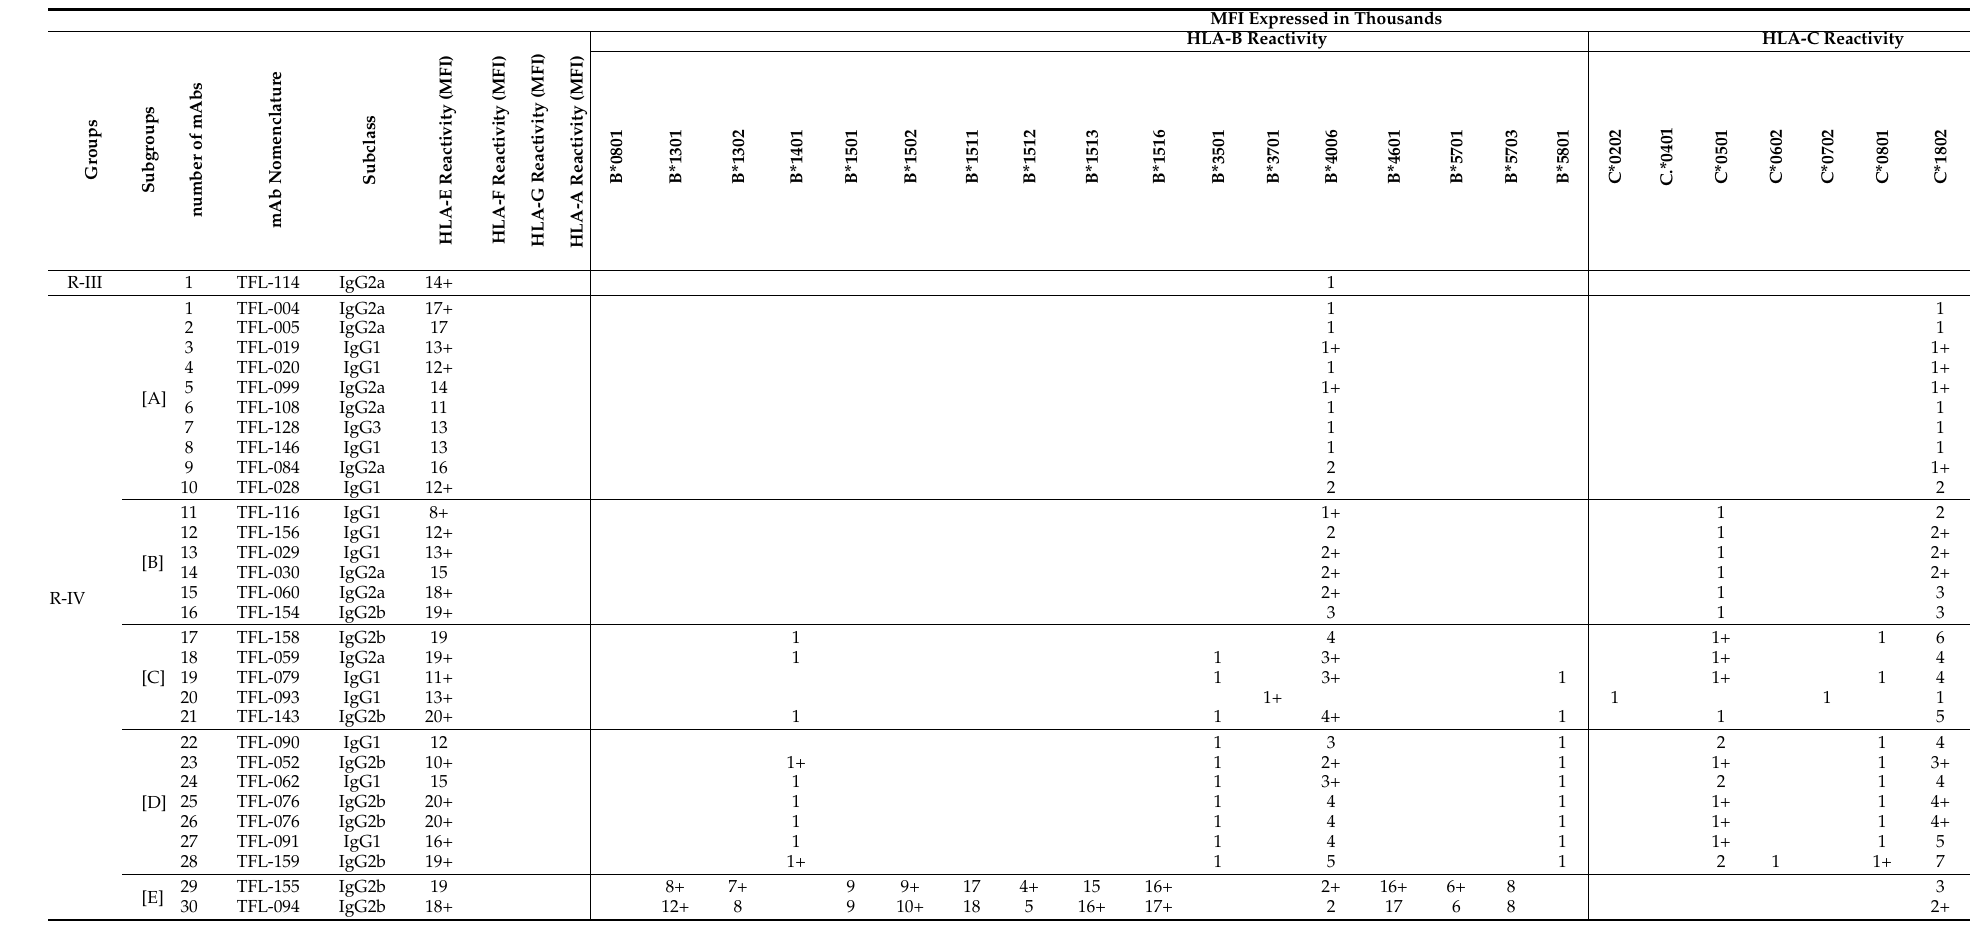
Table 4. HLA-E R mAbs: HLA-F, HLA-G, and HLA-A non-reactive but reactive to HLA-B and HLA-C